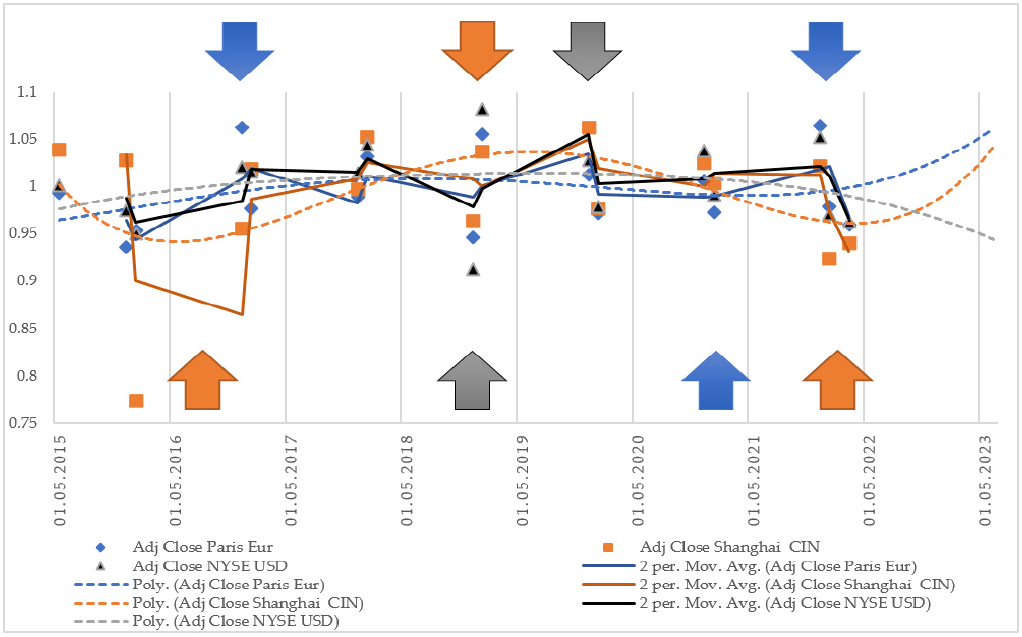
Figure 7. Analysis of the trend correlation of volatile indices at adjusted values. Source: Authors’ Figure 7. Analysisofthetrendcorrelationofvolatileindicesatadjustedvalues. Source: Authors’calculations. calculations